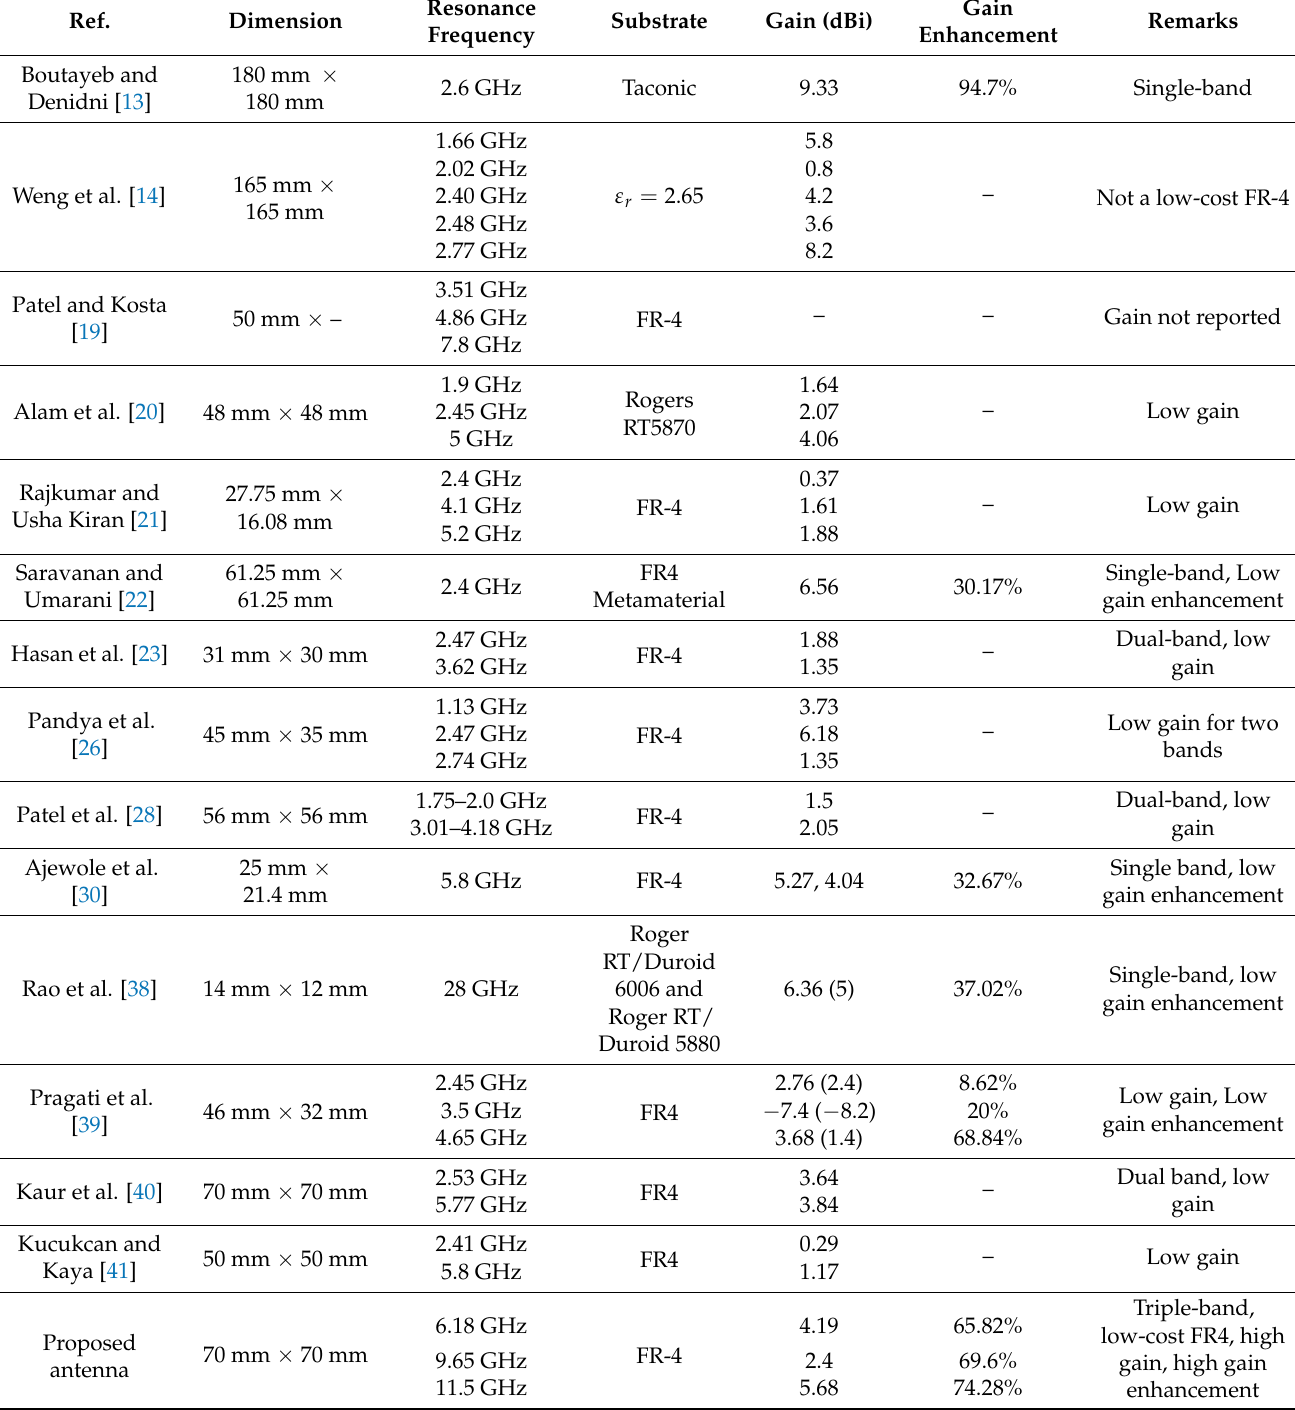
Table 7. Comparison of the proposed antenna with the related